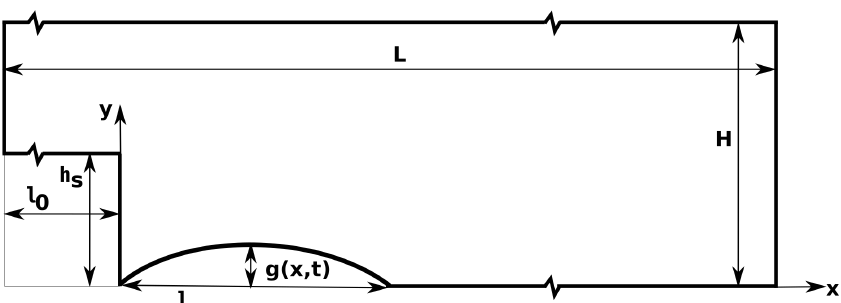
Figure 1. Backward facing step with portion l of moving bottom wall. The inlet lies at x = − l 0 and the outlet at x = L − l 0